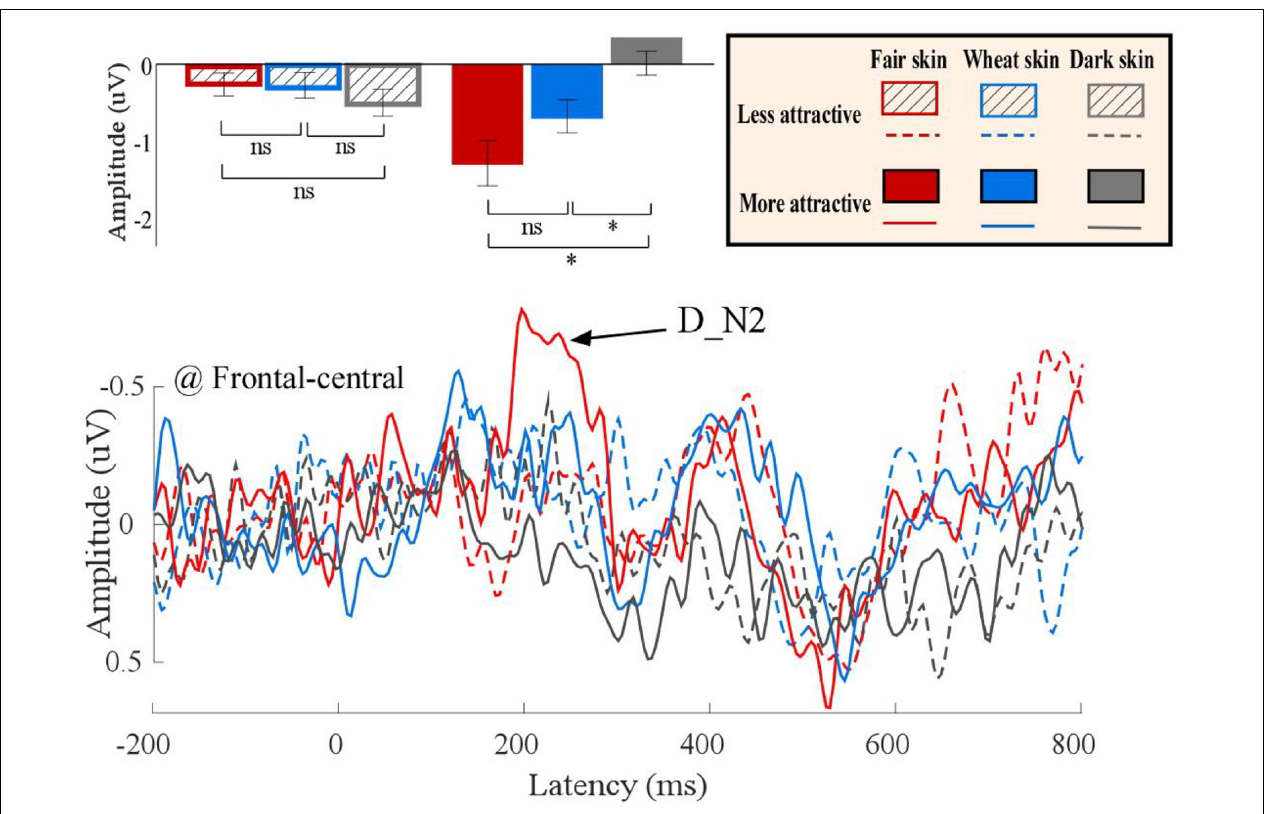
FIGURE 6 | Differential event-related potential (ERP) waveforms between painful and non-painful pictures. Differential ERP waveforms (bottom panel) of more (solid) and less (dotted) attractive faces with fair (red), wheat (blue), and dark (gray) skin. The D_N2 amplitudes are shown in bar charts and are expressed as means ± standard error of the mean (top panel). ns: p > 0.05, ∗ p < 0.05, ∗∗ p < 0.01, ∗∗∗ p < 0.001. TABLE 2 | Summary of statistical analyses of amplitudes of differential event-related potential (ERP) waveforms. Attractiveness Skin color Attractiveness × Skin